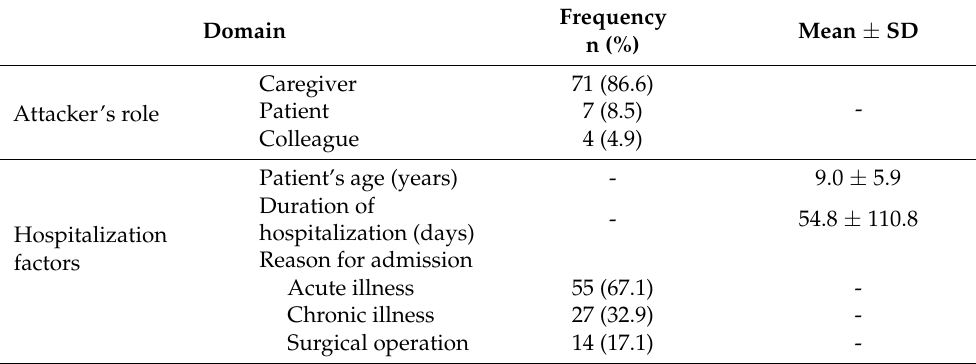
Table 4. The attacker’s role and hospitalization factors related to aggressive acts.